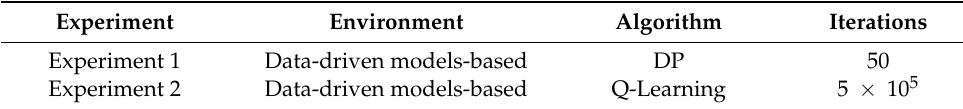
Table 5. Description of the experiments presented.